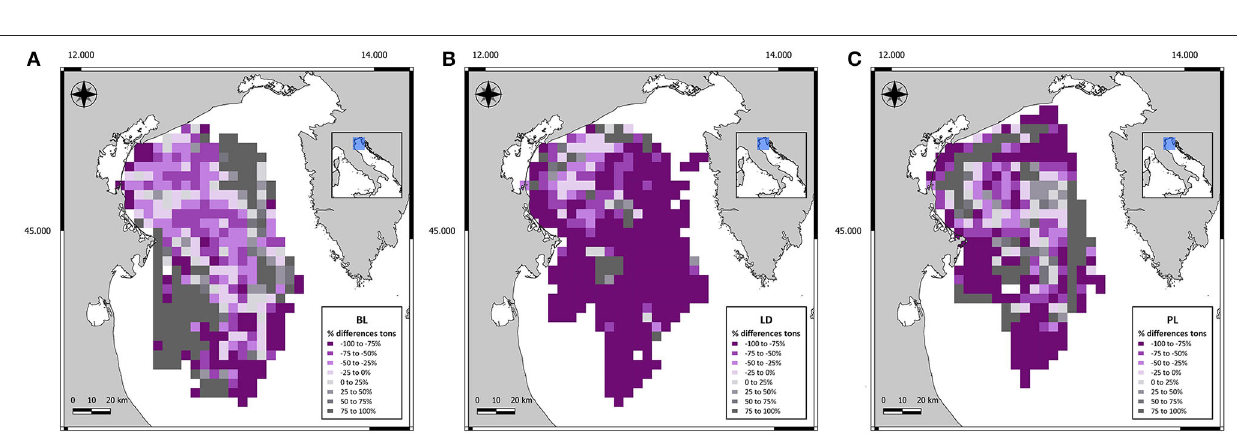
FIGURE 5 | Comparison of the quantity of landings recorded in 2019 and 2020 (expressed as percentage) during the three periods [BL: before lockdown (A) , LD: lockdown (B) , and PL: post-lockdown (C)